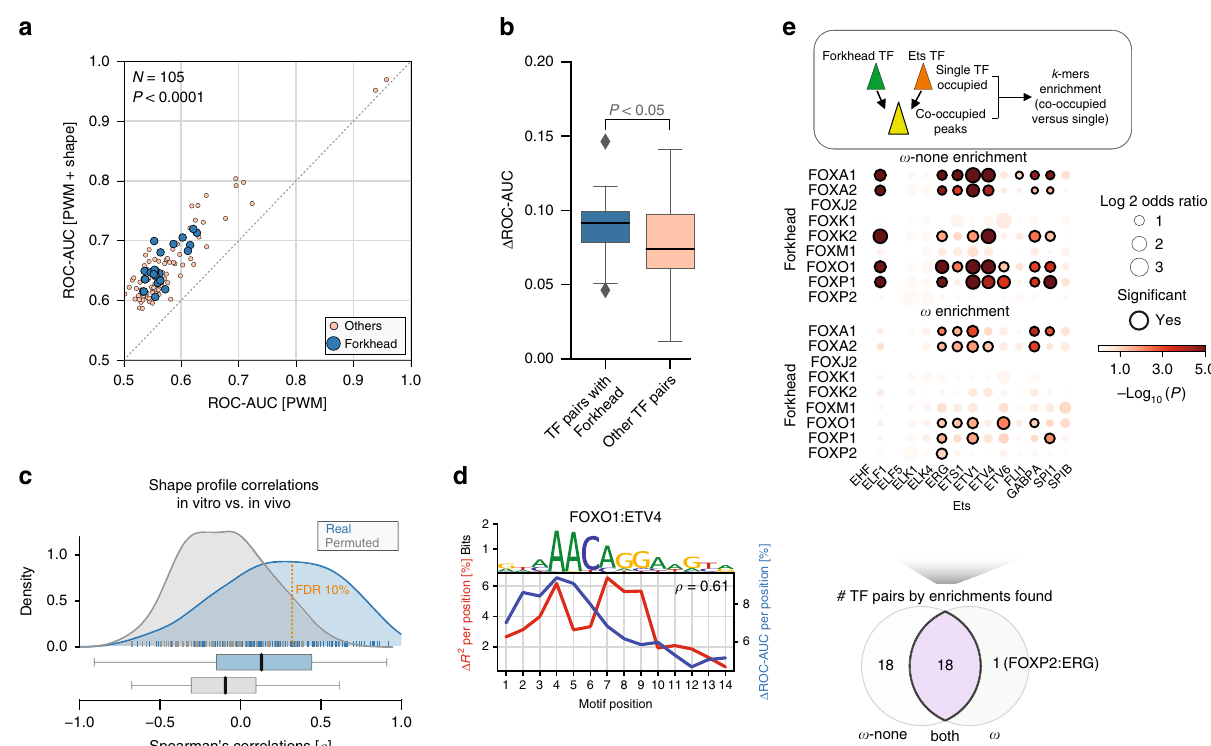
Fig. 4 Cooperative TF binding in vivo and agreement with in vitro derived models. a Classi fi cation performance comparison between PWM + shape ( y - axis) vs. PWM models ( x -axis) in regions that were selected for being co-bound by ChIP-seq for TF pairs present in CAP-SELEX data ( N = 105). Classi fi cation performance is measured by the area under the receiver operating characteristic curve (ROC-AUC). Blue points indicate TF pairs with Forkhead as one of its members. b ROC-AUC differences between classi fi cation models for datasets containing at least one Forkhead member (blue) and all other TF pairs (pink). p -value derived from Wilcoxon rank-sum test. c Spearman ’ s rho distribution of performance changes per position in in vitro ( R 2 ), and in vivo (ROC-AUC) between matched TF pairs. Orange line indicates FDR 10% cutoff for positive correlations. d Forkhead-Ets composite motif model between FOXO1 and ETV4 (top), aligned performance changes per position observed in in vitro (CAP-SELEX; red line) and in vivo (ChIP-seq; blue line) (bottom). ρ indicates effect size. e Scheme illustrating co-enrichment calculations for ChIP-seq regions co-occupied between Forkhead and Ets vs. single TF occupied (top). Dot plot showing ω -none and ω k -mer enrichments between co-occupied and single TF peaks (adjusted p -values obtained from a Fisher ’ s exact test between fraction of regions with motif in co-occupied peaks versus fraction of region with motif in single TF occupied peaks) (middle). Venn diagram indicating signi fi cant observation for tested k -mers, and number of datasets with enrichments for both